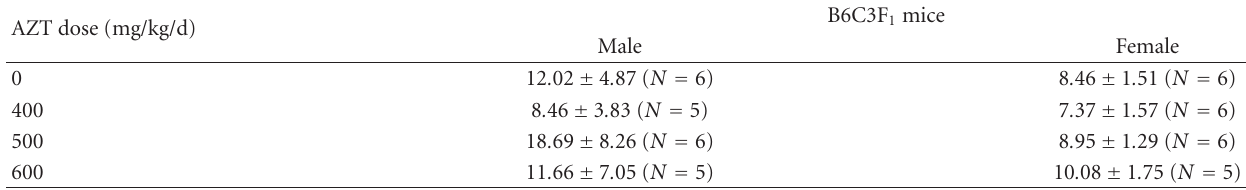
Table 4: Relative mitochondrial DNA (mtDNA) copy number in the livers of B6C3F 1